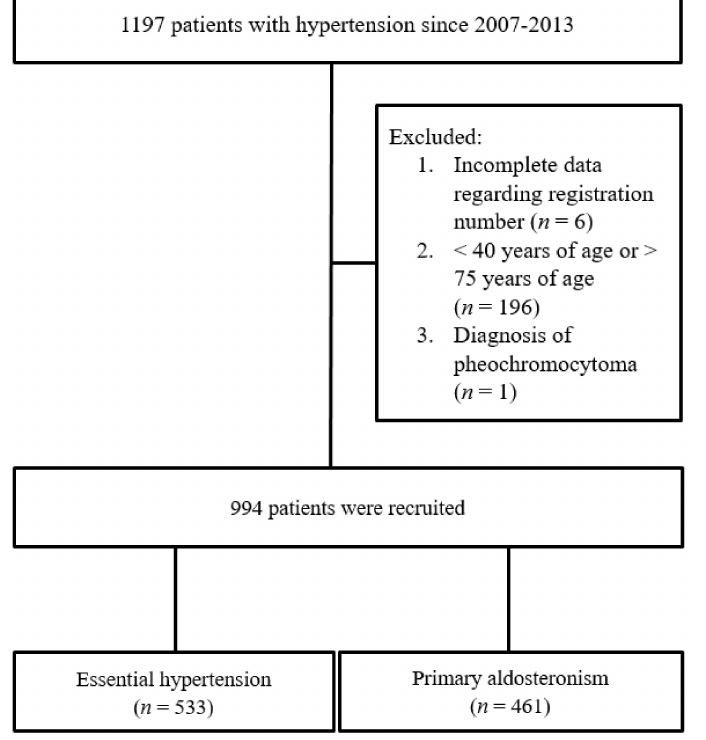
Figure 1. Flow diagram of the study